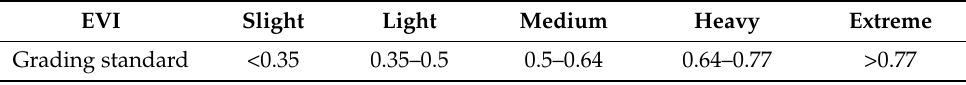
Table 6. Classification of the ecosystem vulnerability index (EVI). EVI Slight Light Medium Heavy Extreme Grading standard